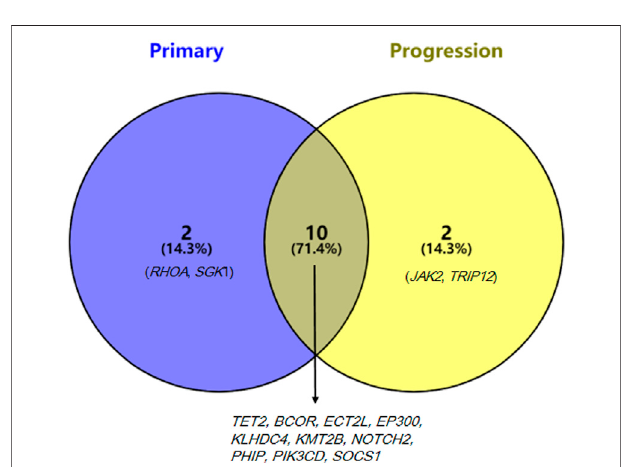
FIGURE 3 | Mutated genes of the primary and progression